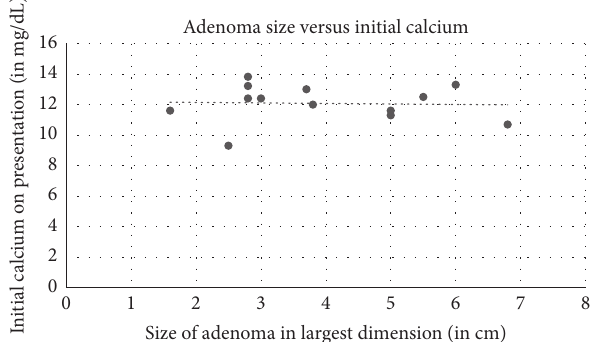
Figure7:Weightofadenomaonpathologicalevaluationcorrelation to initial PTH on presentation. Correlation coefficient